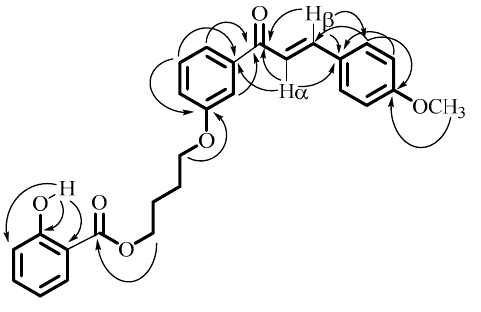
Figure 2. The important 1 H- 13 C correlations in the HMBC spectra of the title compound .